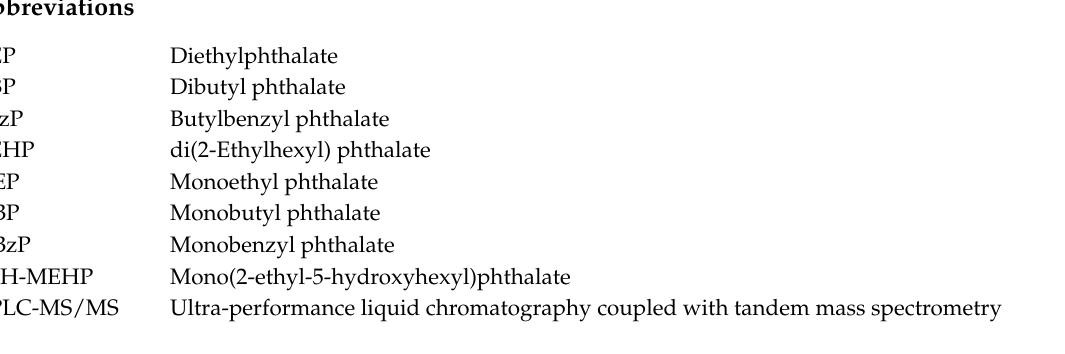
Table S1: Selected characteristics of participants in the CEAS